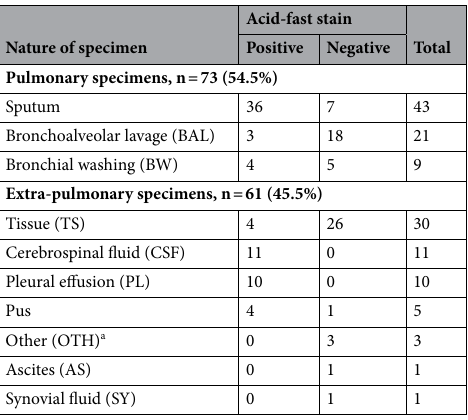
Table 1. Frequency of clinical specimens on the type of sample in the study. a Data were not actualized for various